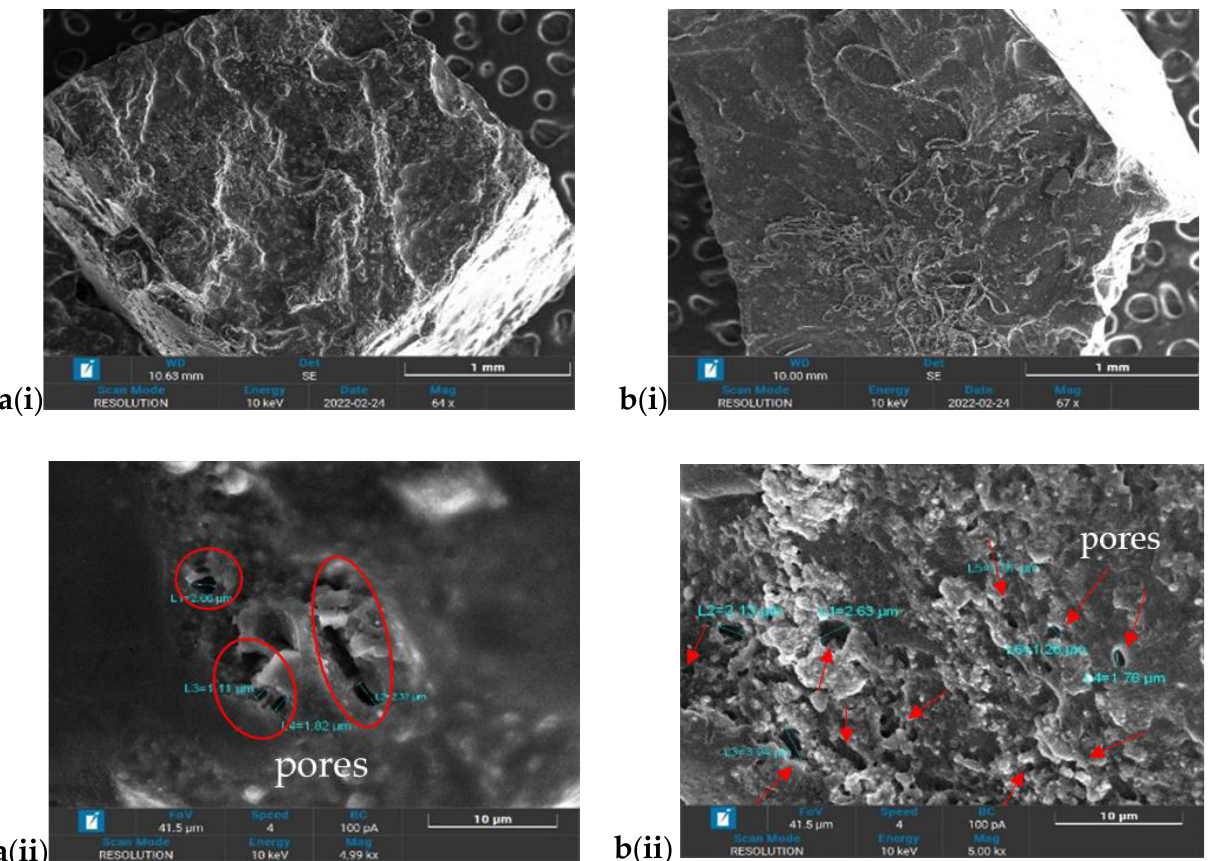
Figure 3. SEM images of ( a ) AAc/AAm and ( b ) 0.5FA-AAc/AAm at ( i ) 64 × magnification and ( ii ) 5000 × magnification; the red circles and arrows points the pores on the hydrogel surface.